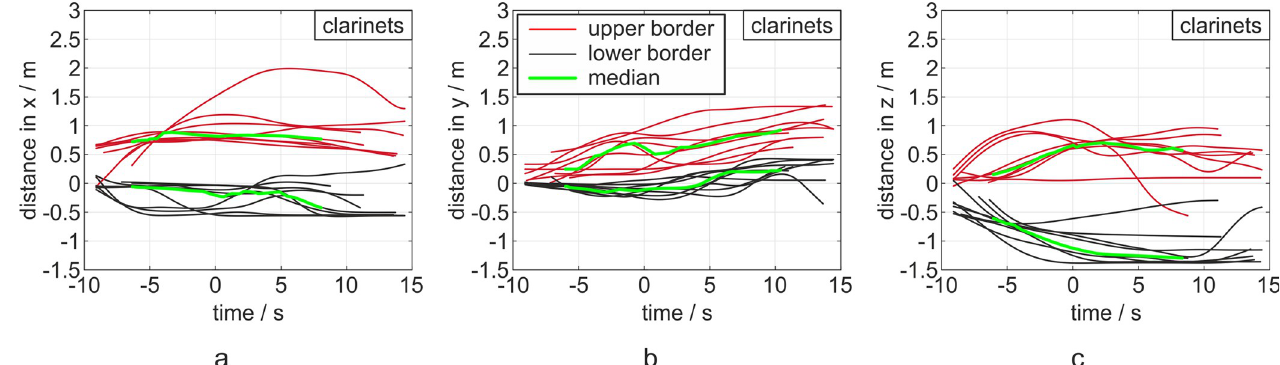
Fig 6. Diagrams of distances in x-, y- and z-direction (a, b, c) from left to right for the clarinets. The 0 point in the time-scale refers to the end of the task. Each task is represented by a red (upper border) and a black curve (lower border) indicating the maximum distances of the cloud in the respective directions. The median devolution in both directions is shown in green. The corresponding diagrams with color-coded notation of the three tasks are displayed in the S3 Fig.